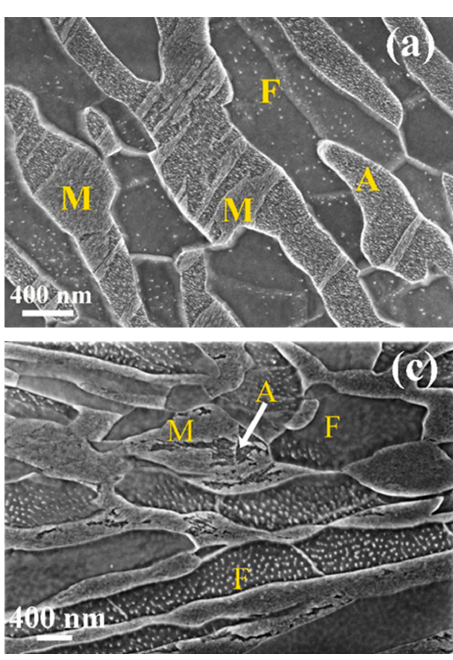
Figure 3. Microstructure of a specimen tested at room temperature. ( a ) SEM micrograph showing DIM formed in some austenite grains after 22% elongation. ( b ) SEM micrograph showing nearly all austenite grains have transformed into martensite at the end of the tensile test. ( c ) SEM micrograph with a higher magnification from the area marked by the arrow in ( b ) showing partially transformed austenite grains. ( d ) EBSD phase map of ( b ), showing virtually all grains have been indexed as bcc phase (ferrite or martensite). F: ferrite, A: austenite, M: martensite. Blue color represents fcc phase, red color represents bcc phase, and black color represents unindexed points. White stars are registration marks. In the specimen tested at 75 °C to fracture, both DIM and the retained austenite were observed, as shown in Figure 4. Some untransformed austenite areas were marked by ar- rows in Figure 4b. Comparing Figures 3d and 4c, one can find more austenite phase in Figure 4c, indicating that increasing test temperature could suppress DIM transformation. The austenite fraction after tensile test at 75 °C was 15%.